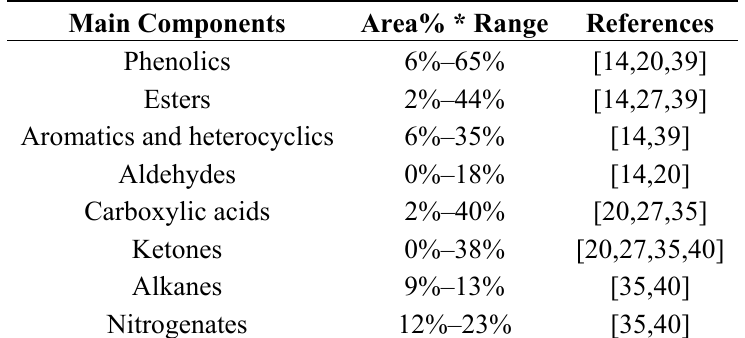
Table 2. Groups of chemicals of hydrothermal liquefaction bio-crude.